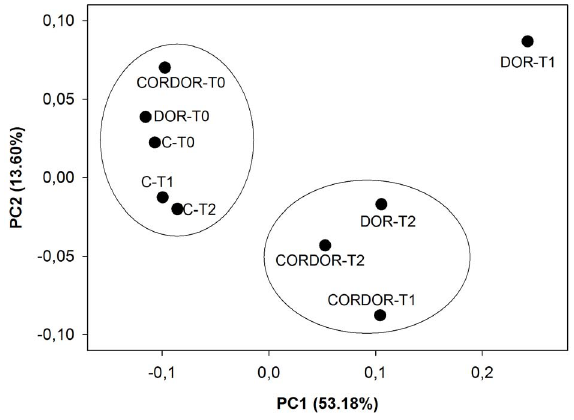
Figure 4. PCoA based on unweighted UniFrac distances of bacterial community found in unamended soil (C) and soil amended with untransformed DOR (DOR) or C. floccosa – transformed DOR (CORDOR) at 0 (T0), 30 (T1) and 60 (T2) days. Percent variability explained by each principal coordinate is shown in parentheses after each axis